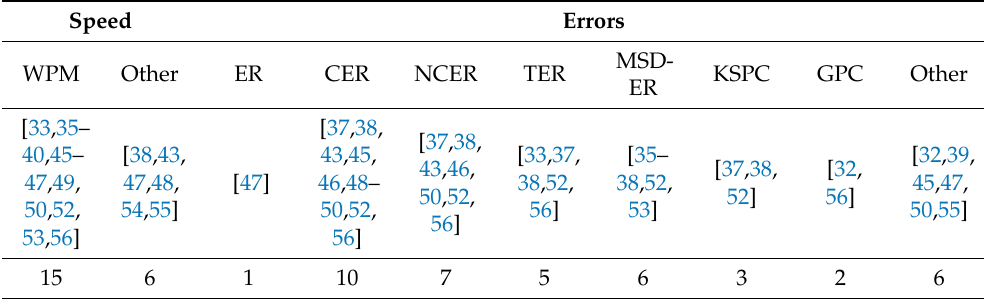
Table 4. Metrics used during main evaluation of VIBP prototypes. The number of papers using each metric is reported in the final row of the table.